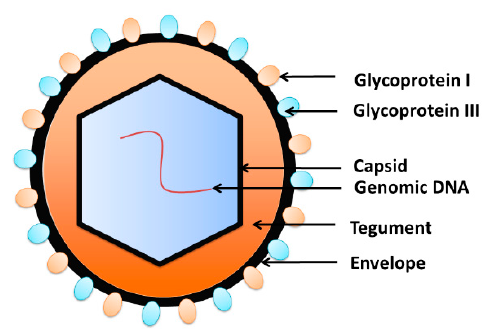
Figure 3. The structure of herpesviruses. The viral DNA is packed inside the capsid, which is wrapped by the tegument. The envelope, the outer layer of the virion, is composed of the phospholipids bilayer embedded with